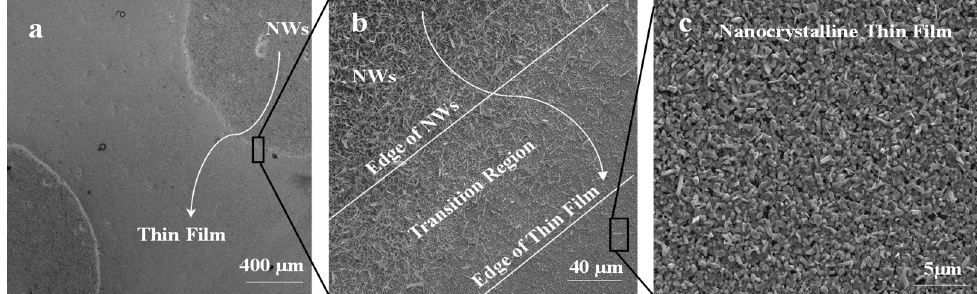
Figure 5. Ga 2 O 3 NWs grown on quartz at 1000 ◦ C. ( a ) Top view of Ag circle pattern which was converted into dense NWs and surrounded by a nonuniform coating of thin film. ( b ) Interface of Ag-coated area and uncoated region shows a gradual transition of NW growth to thin film. ( c ) Nanocrystalline thin film of Ga 2 O 3 is due to surface di ff usion of silver nanoparticles (Ag